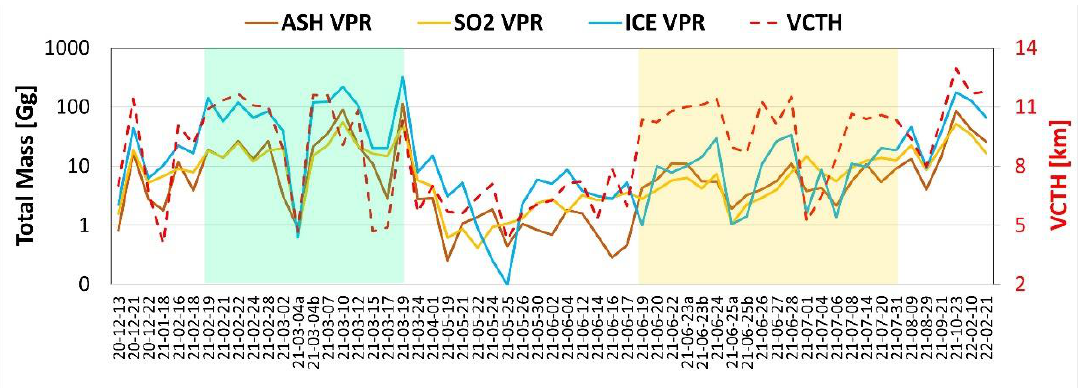
Figure 10. VPR ash/ice/SO 2 total masses and VCTH time series for all the 2020–2022 Etna LFs. The “Date” labels ( x -axis) are in the format year-month-day, with letters a and b to distinguish the LFs that occurred on the same day.